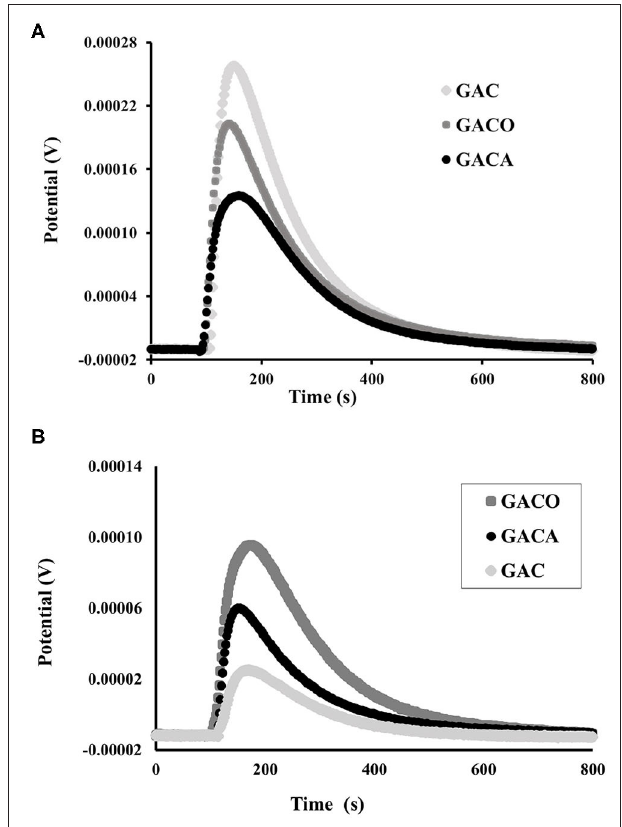
FIGURE 4 | (A) thermogram of the immersion of samples in benzene, (B) thermogram of the immersion of samples in water.